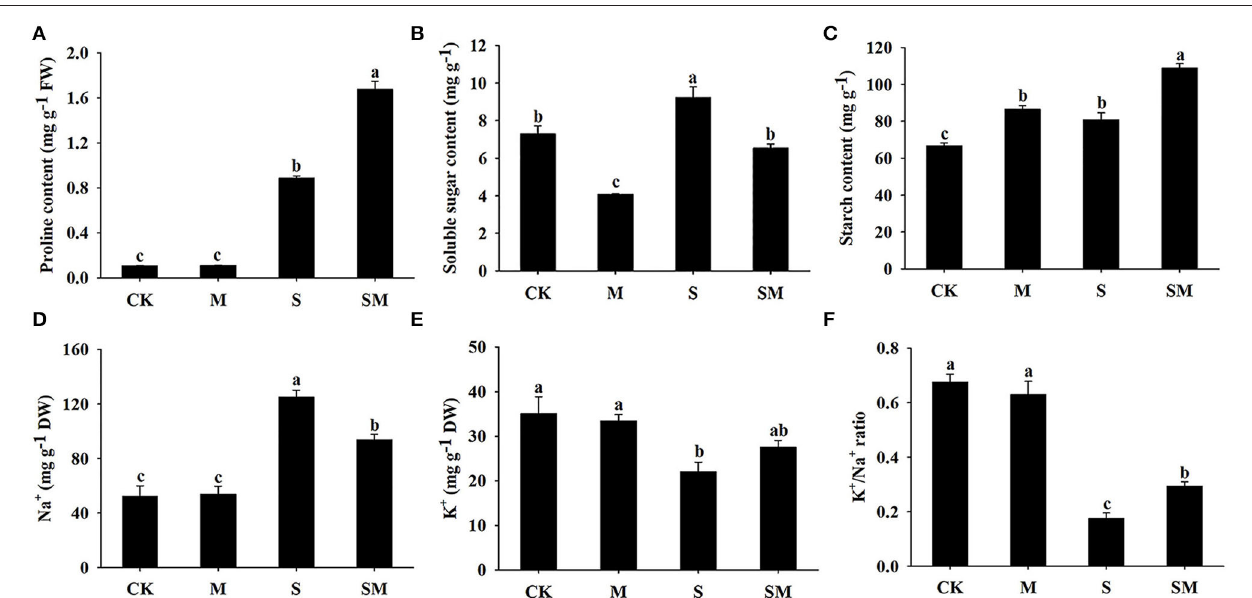
FIGURE 3 | Effect of exogenous melatonin on the contents of (A) proline, (B) soluble sugar, (C) starch, (D) Na + , (E) K + , and (F) K + /Na + ratio of alfalfa seedlings after 15 days of 150-mM NaCl treatment. The data are means ± SE ( n = 3) and different letters are significantly different ( p <